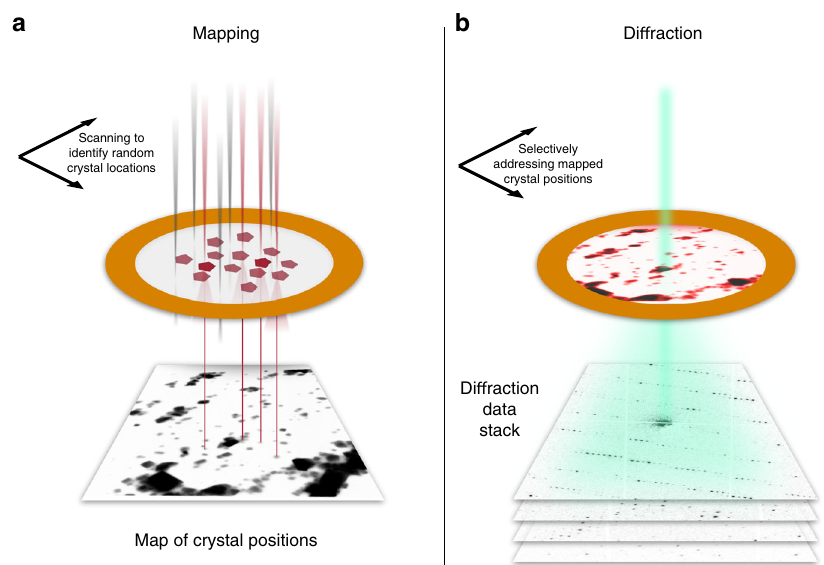
Fig. 1 Serial nanobeam electron diffraction scheme. a The sample is fi rst mapped in low-dose STEM mode over a large region (typically ≈ 20 µ m edge length), yielding a real-space image. Crystals show up as clear features and can be identi fi ed automatically. b The beam of ≈ 100 nm diameter is sequentially steered to each found crystal position, and diffraction patterns are acquired at a rate of up to 1